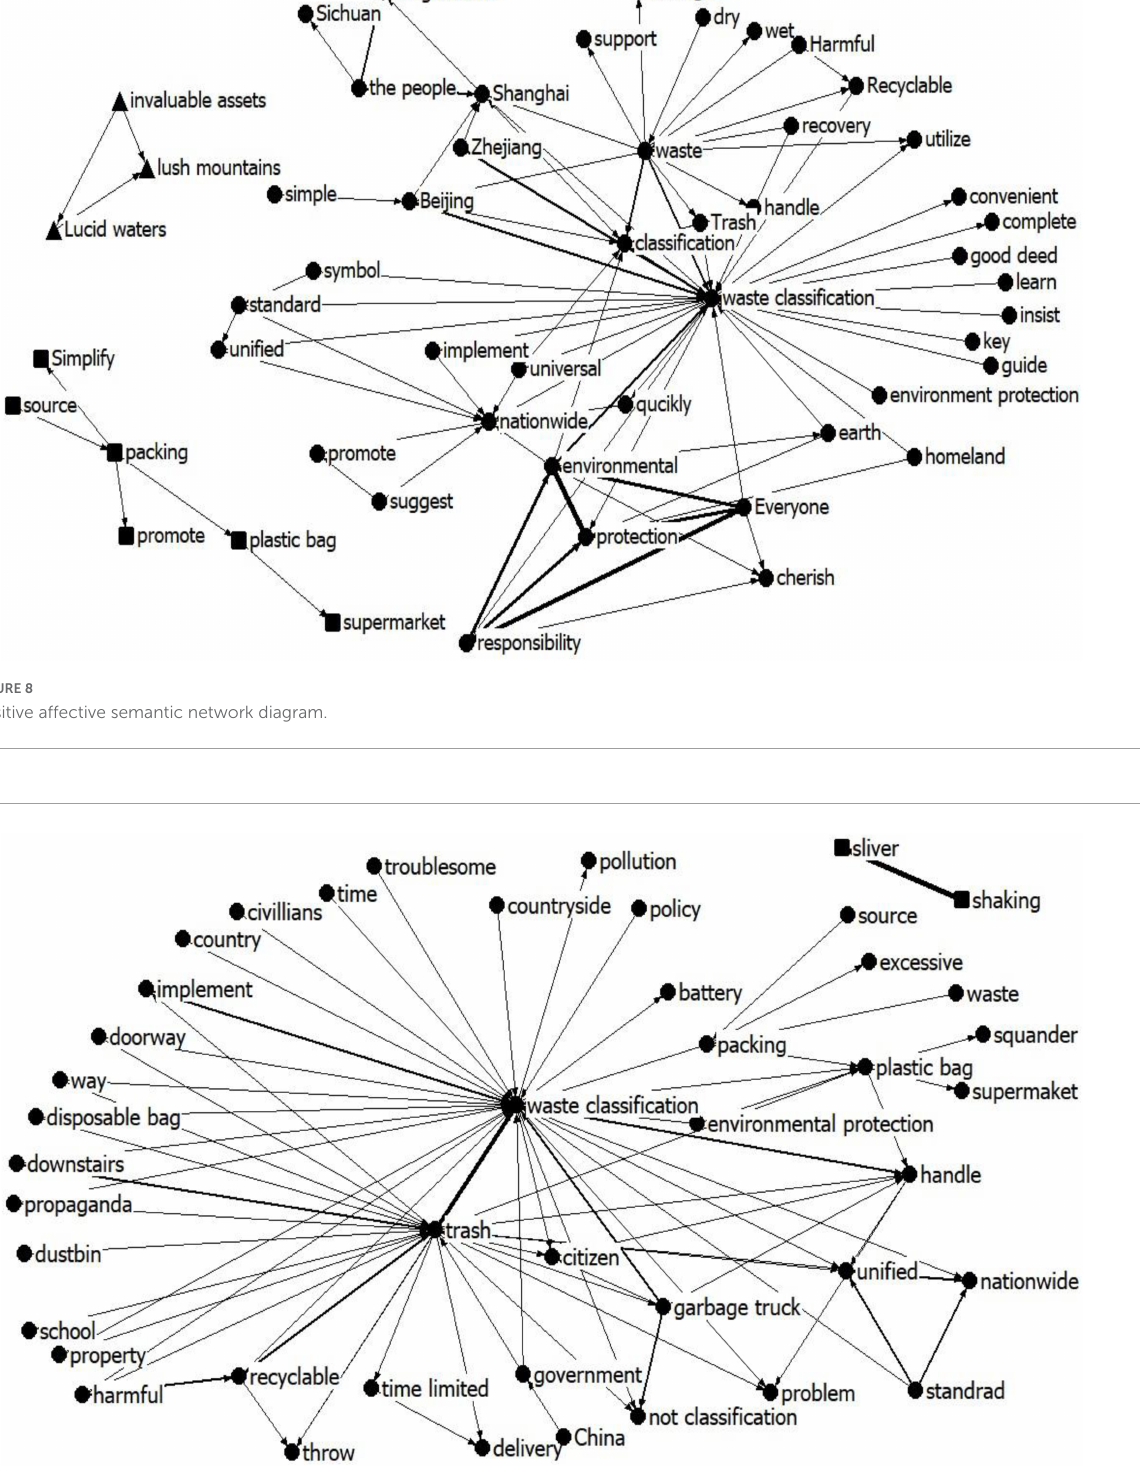
FIGURE9 Negative emotion semantic network